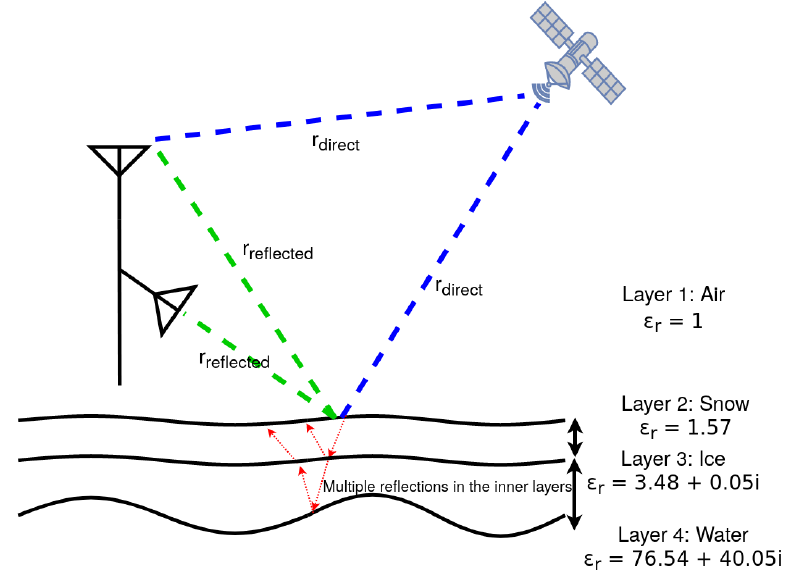
Figure 4. Four-model layer applied to PYCARO-2 instrument in MOSAiC campaign.